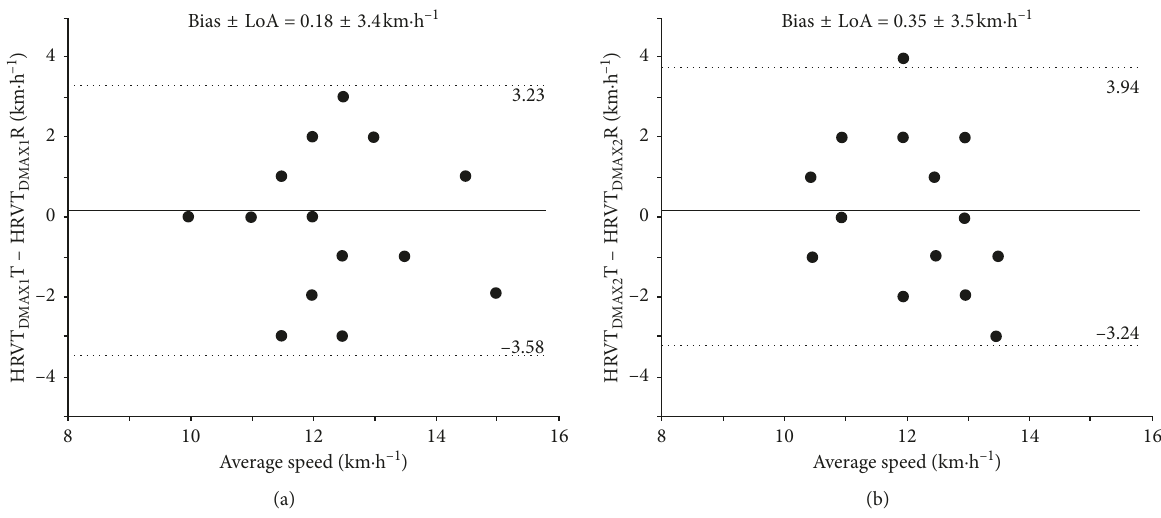
Figure 3: Bland and Altman plot for the reproducibility of HRVT